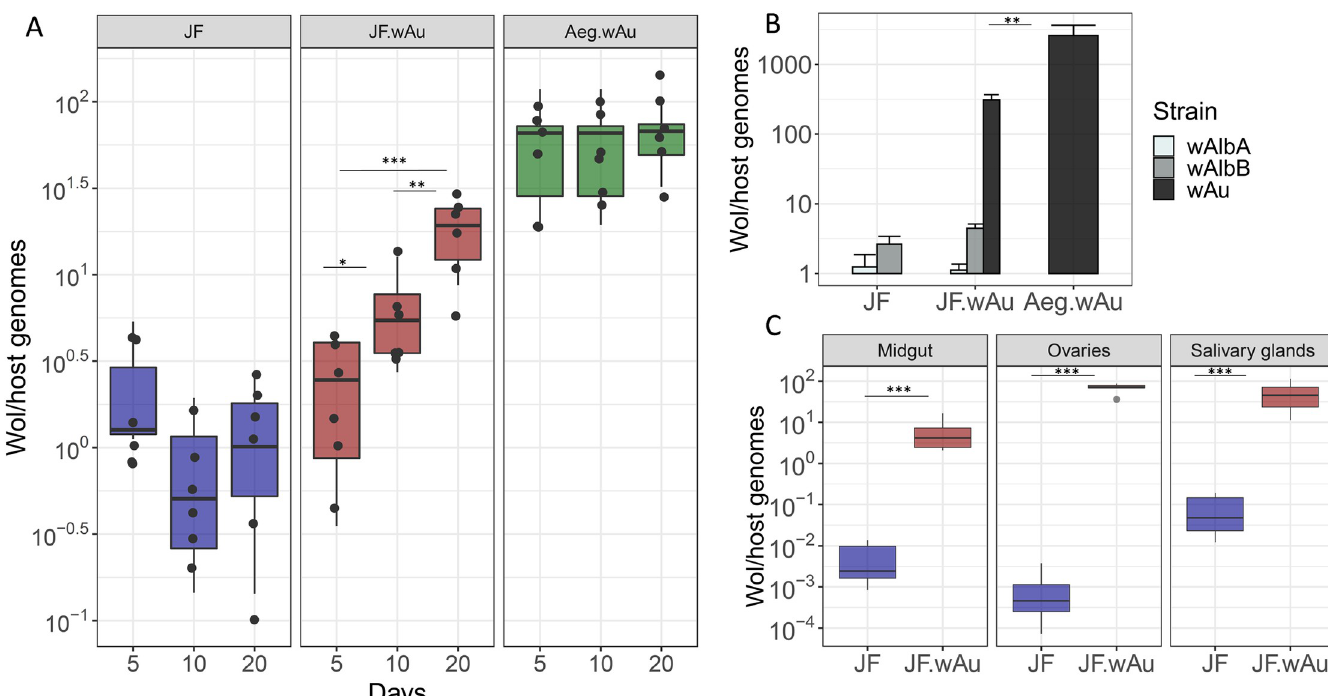
Fig 1. Wolbachia density and tissue distribution. A) 5, 10 and 15 day-old adults were tested for total Wolbachia density. Boxplots represent 6 biological replicates: the centre indicates the median of densities and whiskers represent upper and lower extremes. B) Strain-specific qPCR was used for assessing the density of each strain of the triple infection. Bars represent the average of 6 biological replicates. Error bars show SE. C) Wolbachia tissue distribution was measured in 6 pools of 3 sets of dissected ovaries, salivary glands and midguts. t-test and Mann-Whitney test were used for statistical analyses. � p < 0.05, �� p < 0.001, ��� p < 00001. Non-significant differences are not